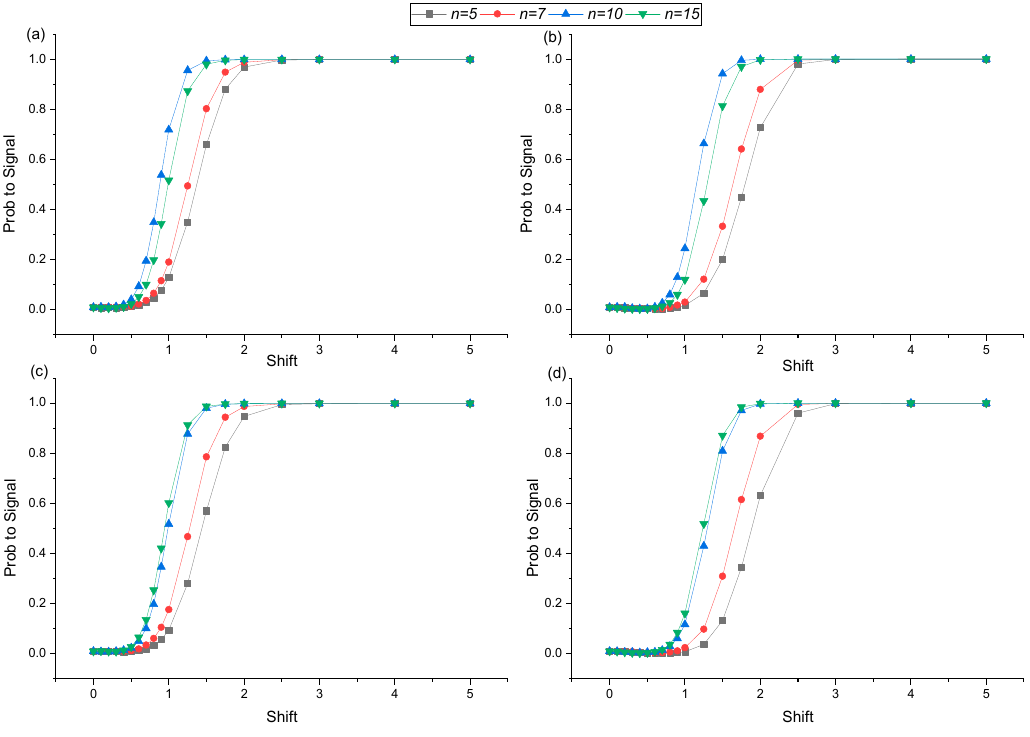
Figure 6. Probability to signal plot for di ff erent sample sizes using m = 30, ρ = 0.95 and α = 0.01 of: ( a ) M 3 and m 1 = 6; ( b ) M 3 and m 1 = 9; ( c ) M 4 and m 1 = 6; ( d ) M 4 and m 1 = 9.